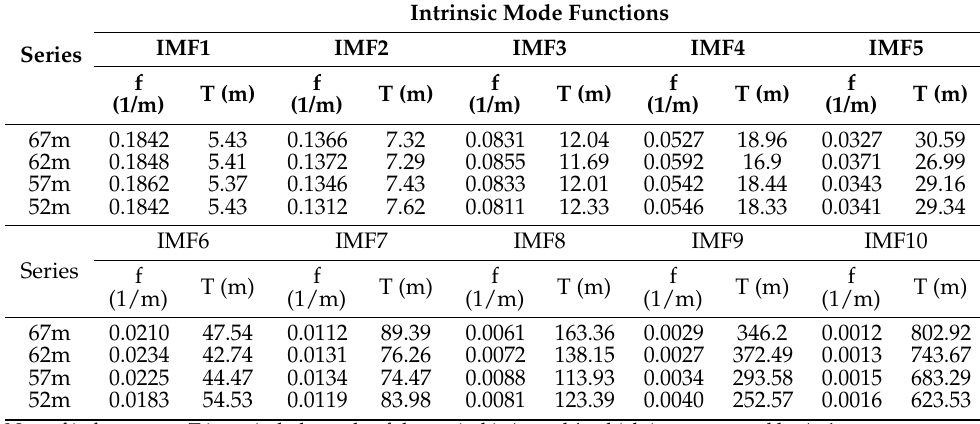
Table 3. The center frequencies and average periods of IMFs from monthly series at Huayuankou station.